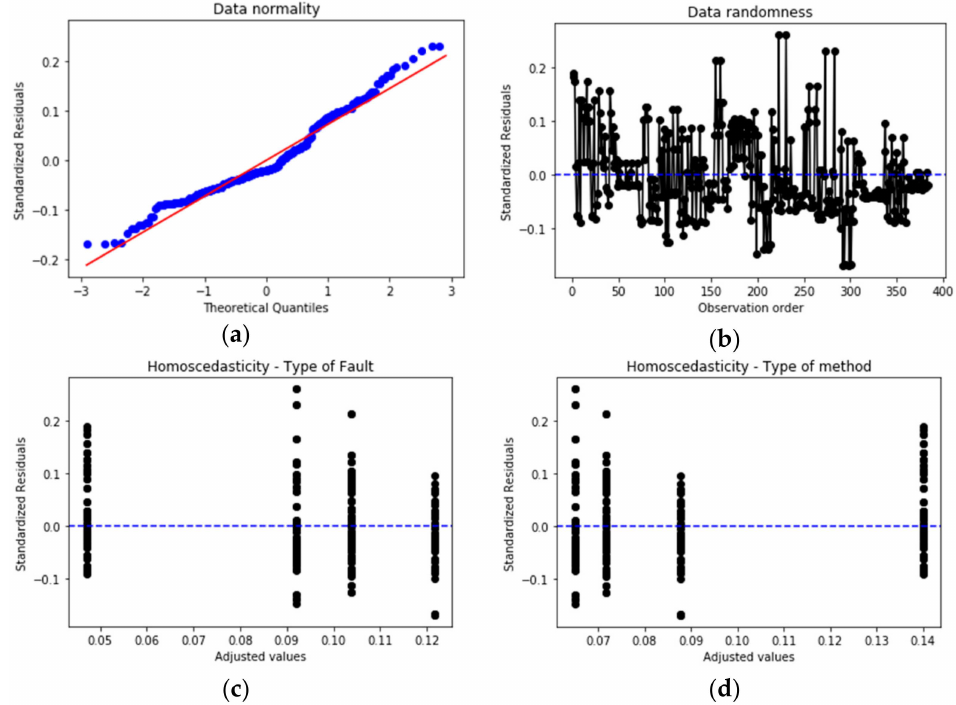
Figure 16. Assumptions for the application of the Anova2 model. ( a ) Data normality; ( b ) Data randomness; ( c ) Homoscedasticity—Type of fault; ( d ) Homoscedasticity—Type of